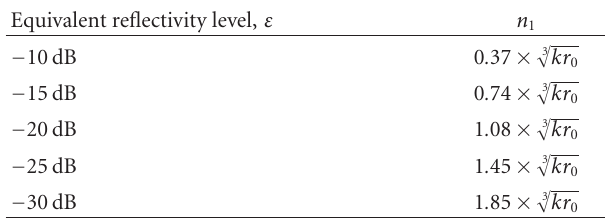
Table 1: The values of n 1 for di ff erent uncertainty levels for the 2D